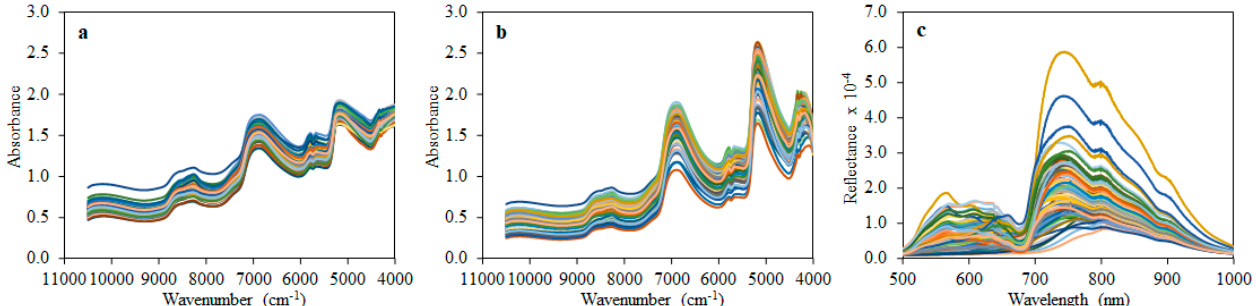
Figure 2. Spectra of olive drupes acquired with: ( a ) FT-NIR integrating sphere; ( b ) FT-NIR fiber-optic probe; ( c ) portable Vis/NIR device.